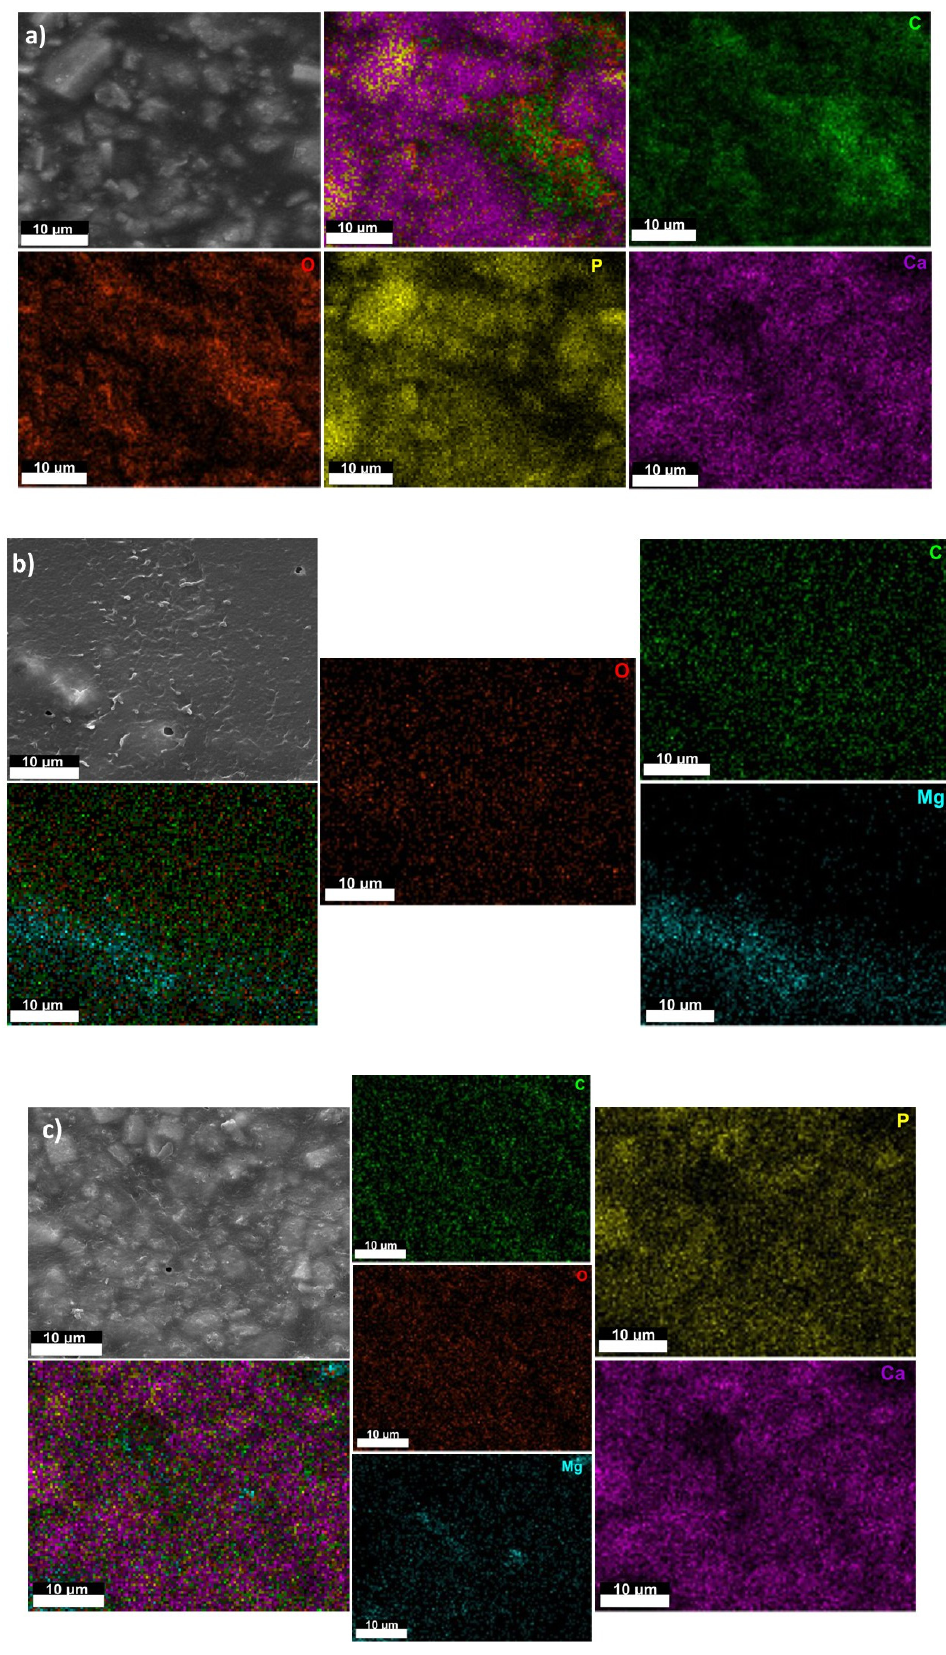
Figure 4. SEM images of the composite sample: ( a ) CA-HAp sample; ( b ) CA-Mg sample; ( c ) CA- HAp-Mg sample.